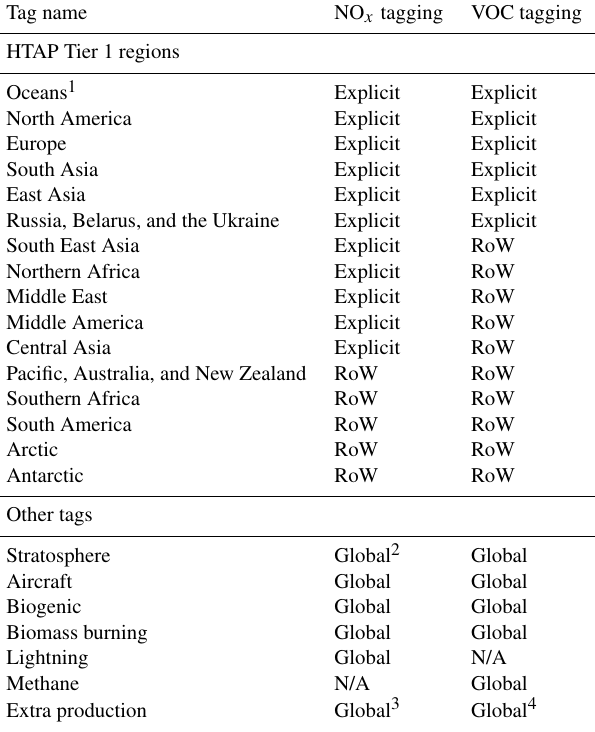
Table 1. List of tags used for the attribution of tropospheric ozone in the NO x - and VOC-tagged runs. Anthropogenic emissions of NO x and reactive carbon are tagged based on their HTAP Tier 1 region. Other tags are as in Butler et al. (2018). RoW refers to “Rest of the